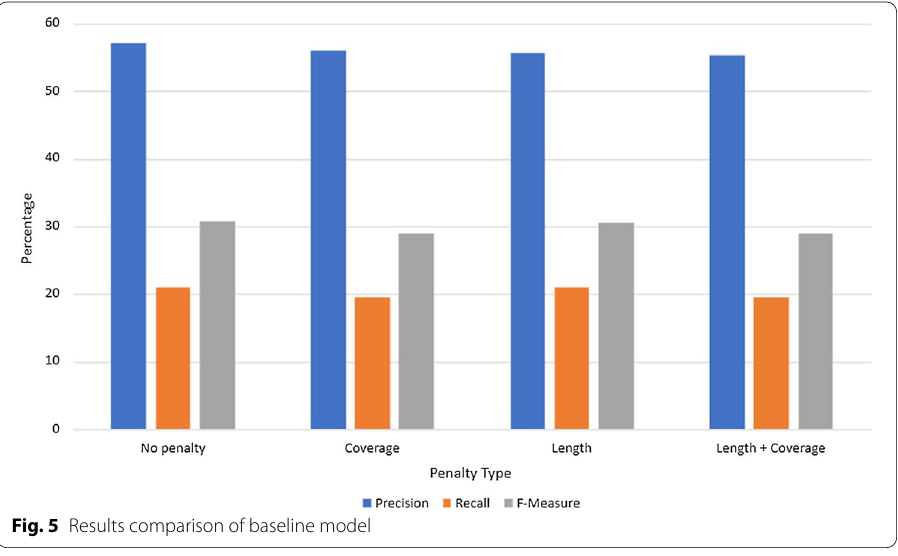
Fig. 5 Results comparison of baseline model